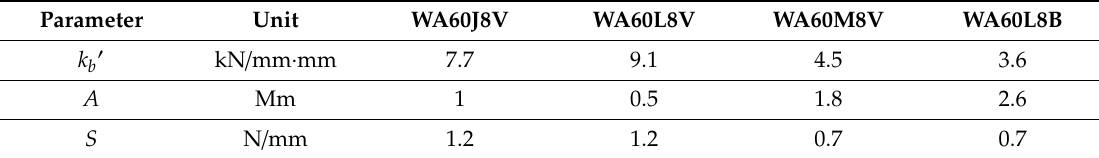
Table 4. Parameters of various grinding wheels obtained by the deflection measurements.